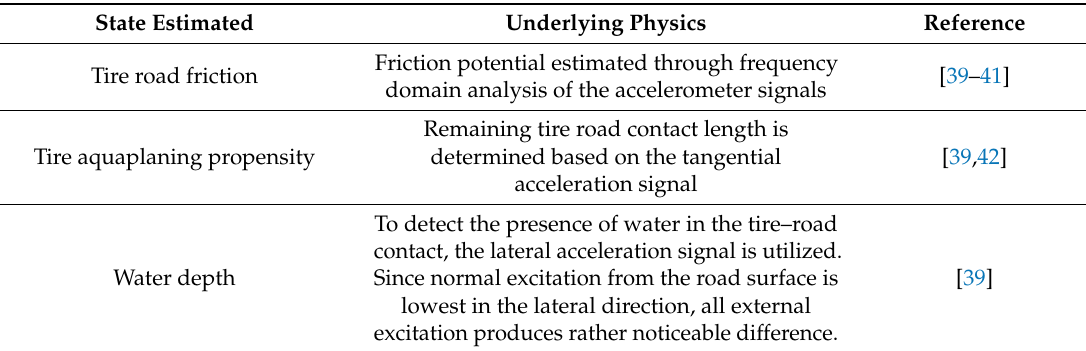
Table 8. State-of-the-Art Literature Review—Intelligent